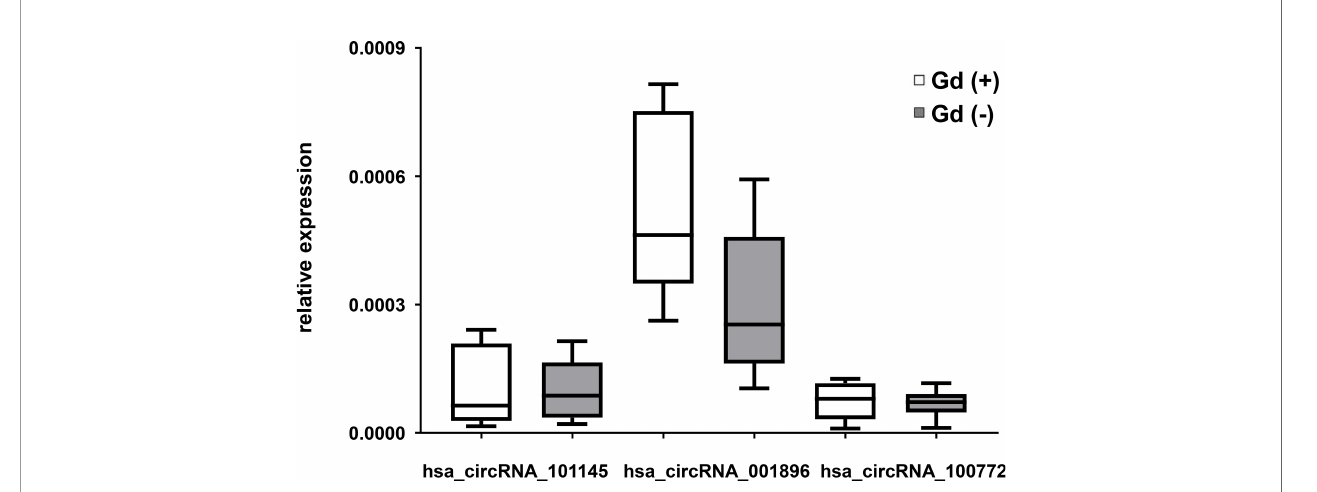
FIGURE 3 | circRNA expression in PBMCs in relation to magnetic resonance imaging activity in RRMS. Box and whisker plots of the relative expression of the indicated circRNAs in PBMCs in gadolinium-enhanced (Gd)+ ( n = 8) and in (Gd) − ( n = 13) RRMS patients. Signi fi cance was determined by Student ’ s t